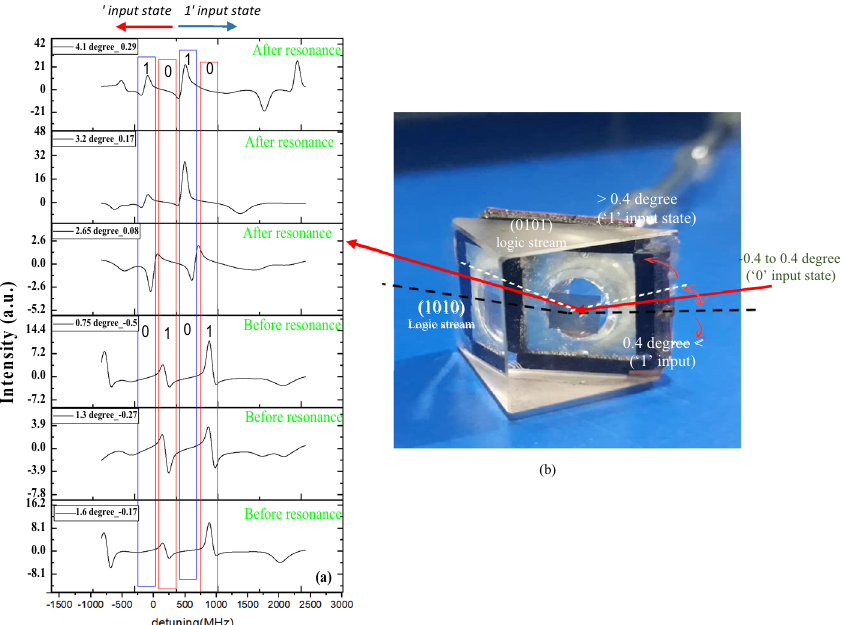
Figure 3. ( a ) reflectance signal from the interface of SP- Rb atomic vapor by wavelength detuning of laser light, under shifts of incidence angle of laser light. ( b ) Produced atomic-plasmonic cell with schematic arrows to represent the possible range of incidence angle, considering input logic states. The red solid arrows indicate the SP resonance incidence angle while the dotted white line shows −0.4 degree before resonance (0101 logic stream) and black dotted line shows 0.4 degree after resonance (1010 logic stream). The range of incidence angles which are considered as 0 and 1 logic inputs are depicted as red curved arrows. All amounts of incoming angles are measured from angle of SP